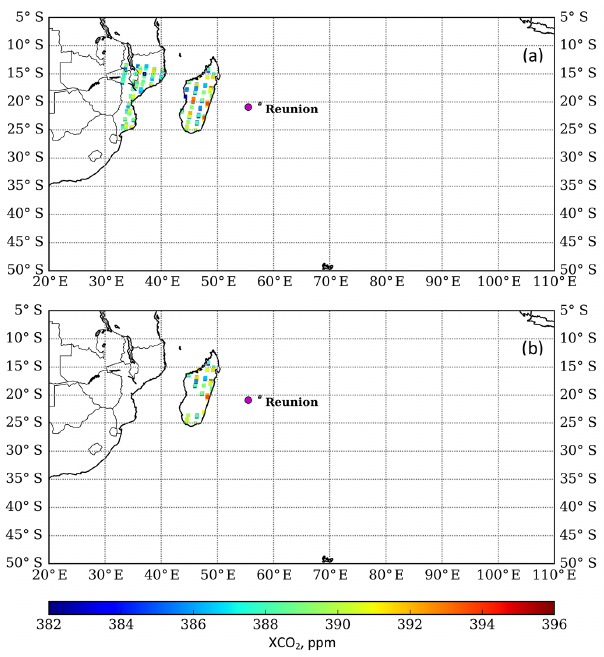
Figure 9. UoL-FP GOSAT XCO 2 observations selected using (a) the geostatistical method within an area of ± 7.5 ◦ ×± 22.5 ◦ and (b) the footprint-based method with the limit log 10 ( x ) =− 2.0.